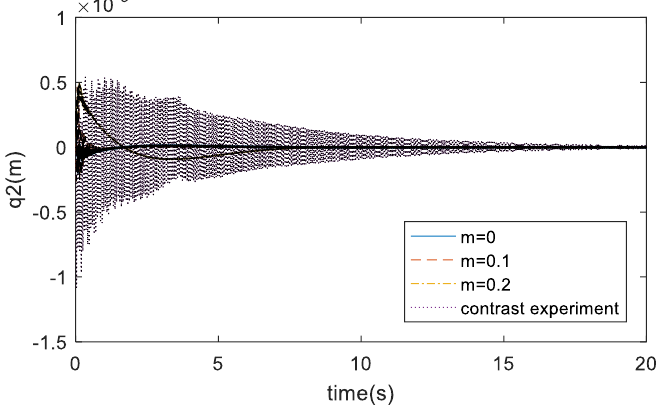
Figure 7. The second mode vibration of flexible